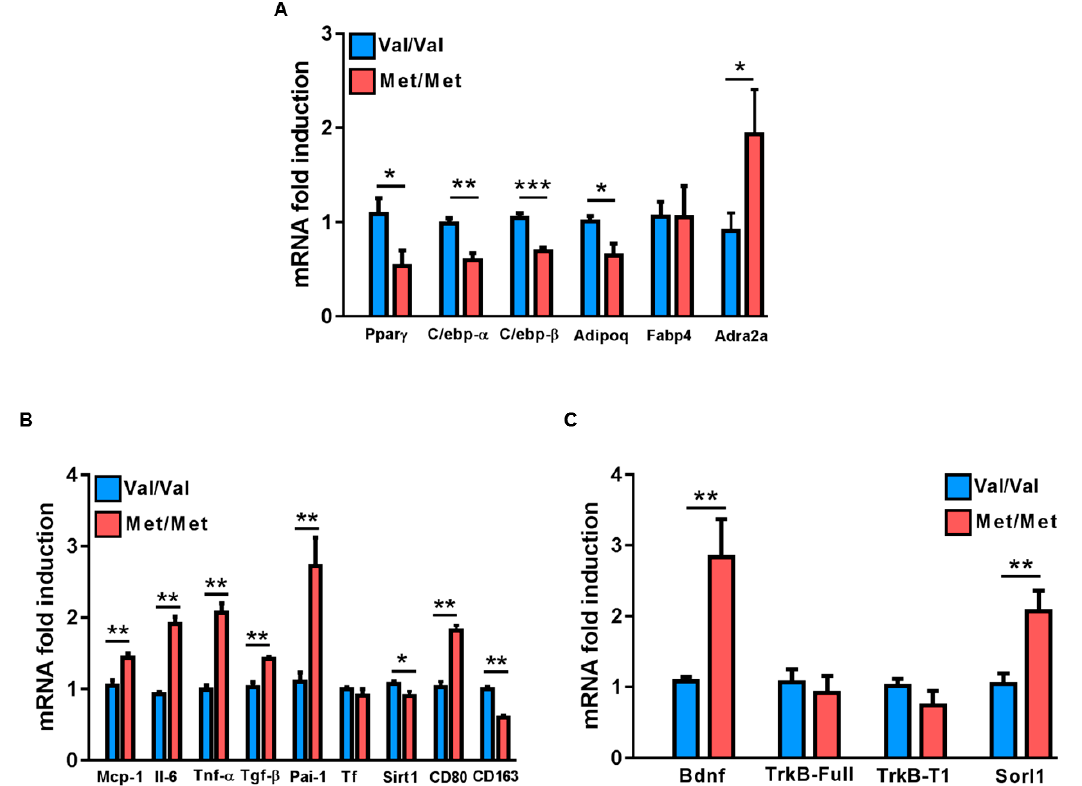
Figure 2. Gene expression profile of epidydimal white adipose tissue (epiWAT) in BDNF Val / Val and BDNF Met / Met mice. mRNA levels of genes related to ( A ) adipogenesis, ( B ) inflammation, and ( C ) BDNF / TrkB pathway in epidydimal white adipose tissue (epiWAT) of BDNF Val / Val and BDNF Met / Met mice. Data are expressed as mean ± SEM. n = 6 mice / group. Student’s t-test. * p < 0.05, ** p < 0.01, and *** p < 0.005.